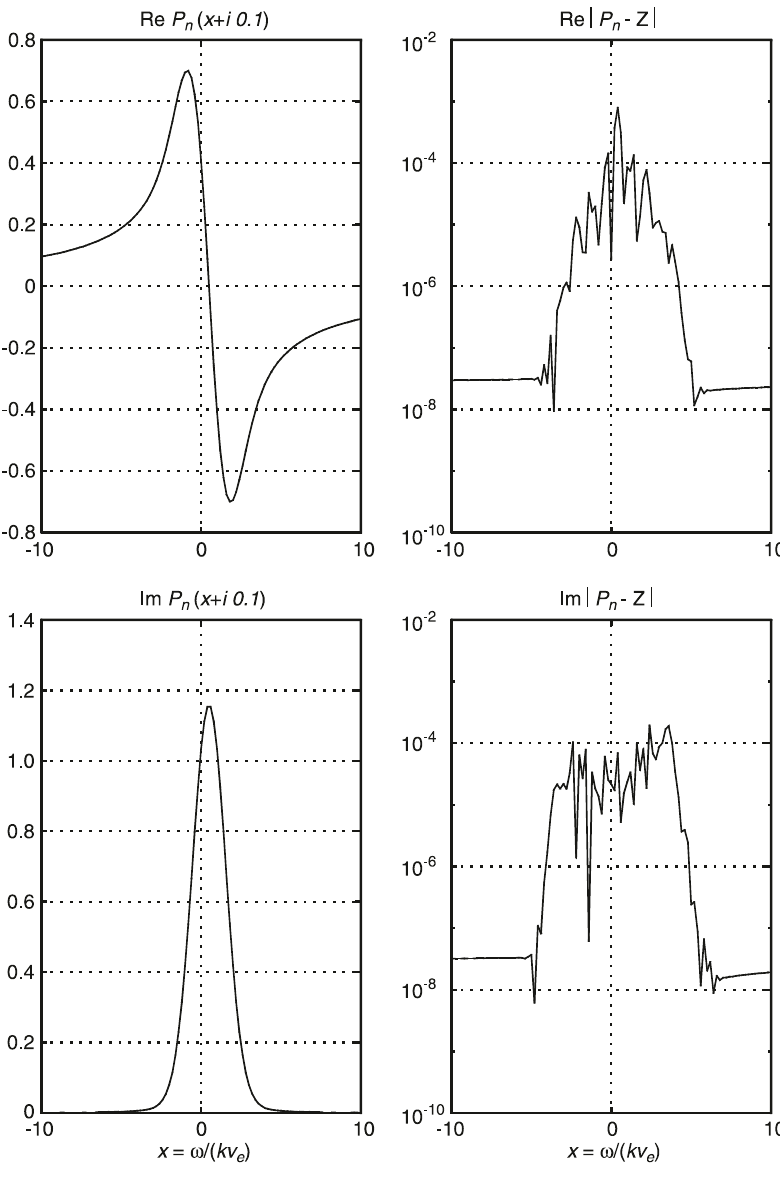
(cid:129)(cid:129)(cid:129) p (cid:129)(cid:129)(cid:129) p 2 (cid:134) = 2 , where Z is